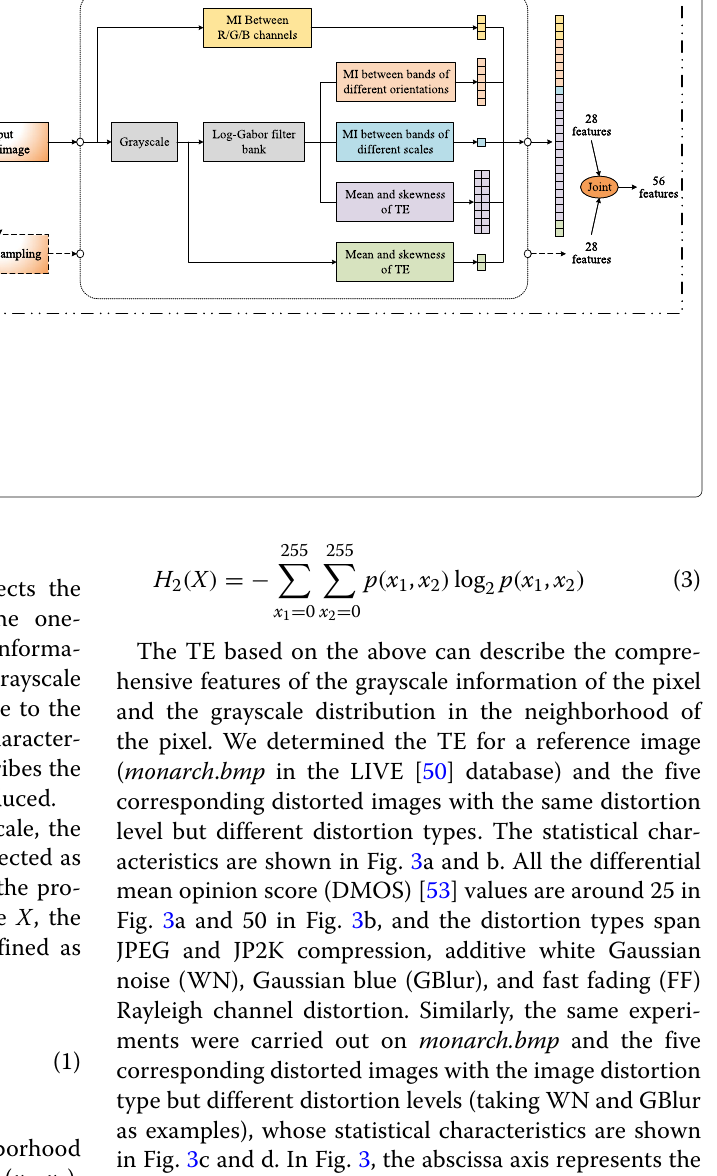
Fig. 1 The framework of the proposed ENIQA method